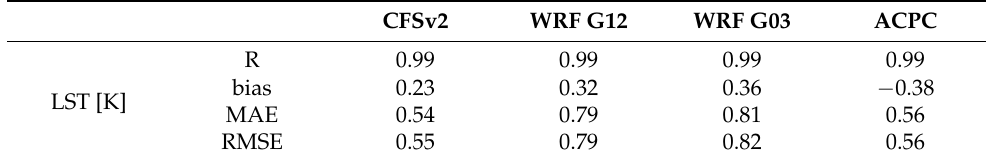
Table 4. Statistical metrics of land surface temperatures (LST) retrieved using atmospheric parameters from different profile sources. The LST values calculated with SBPA parameters were considered as reference values. CFSv2 WRF G12 WRF G03 ACPC R 0.99 0.99 0.99 0.99 bias 0.23 0.32 0.36 − 0.38 LST [K] MAE 0.54 0.79